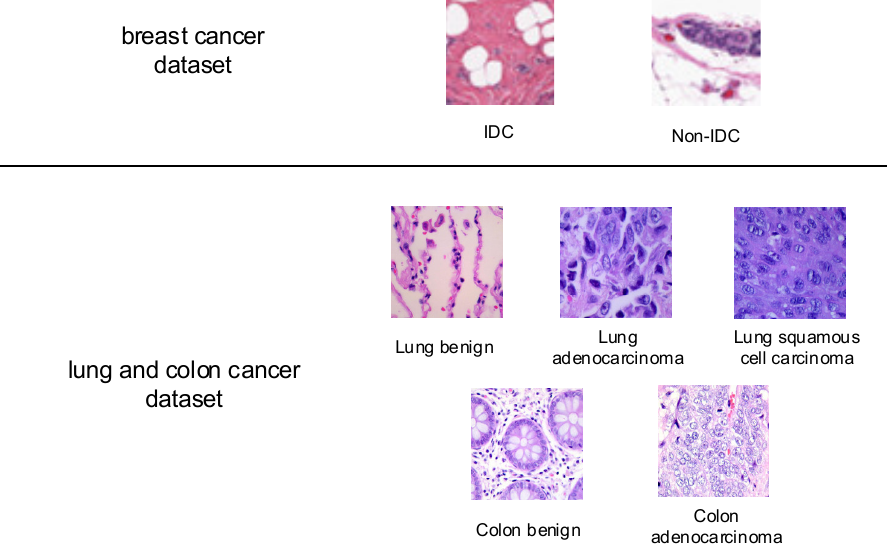
Figure 3. Sample images from breast cancer dataset, and lung and colon cancer dataset.